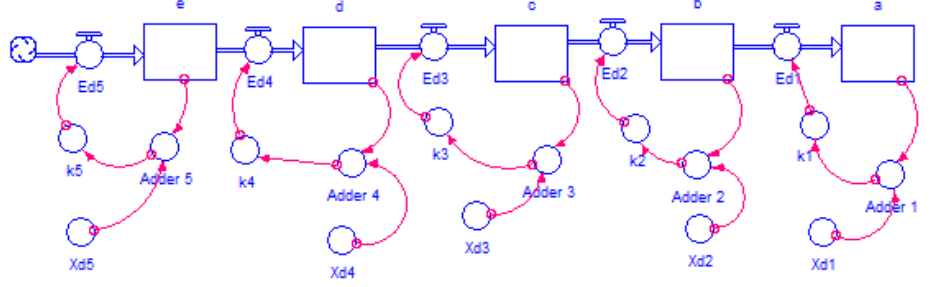
Figure 24. Forrester diagram of the confection process, n = 5.